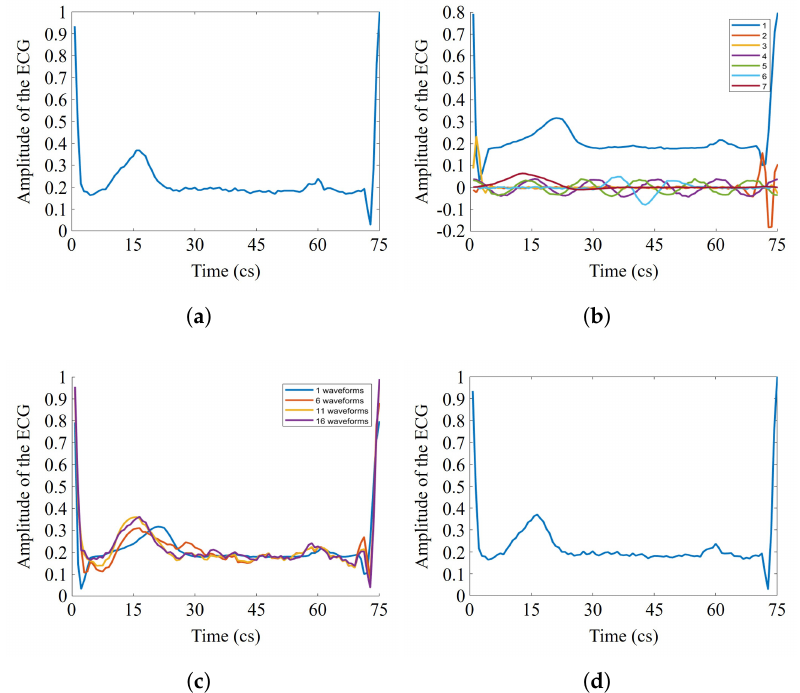
Figure 8. ( a ) Original signal, ( b ) signal decomposition (analysis) in elementary waveforms, ( c ) signal reconstruction (synthesis) by using different number of atoms, and ( d ) signal reconstruction with all numbers of